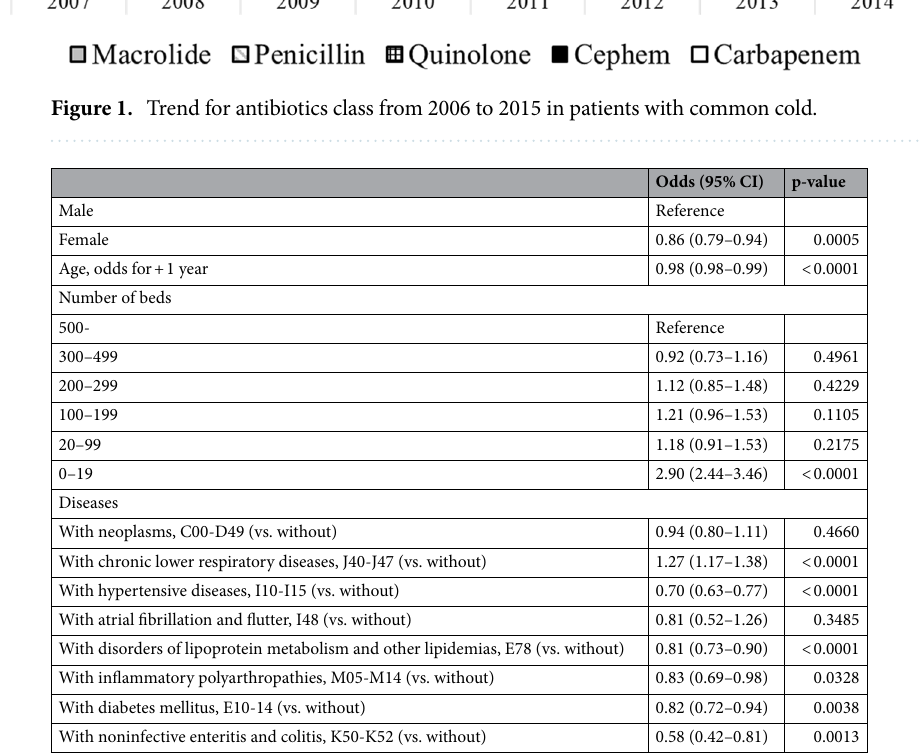
Table 2. Predictive factors for prescribing antibiotics at the time for hospital/clinic visiting caused by common